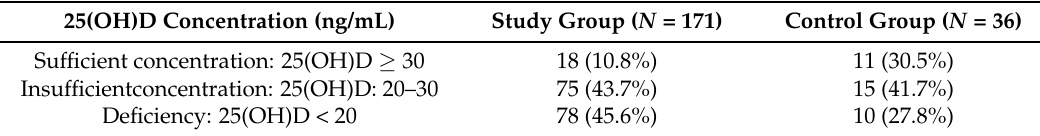
Table 1. Concentration of 25(OH)D (ng/mL) in the study group.